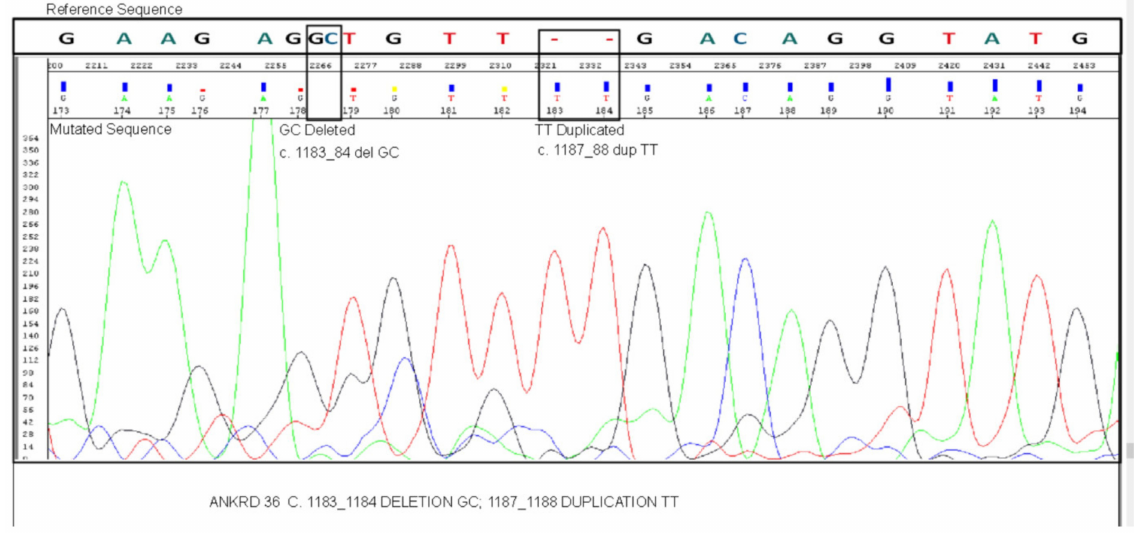
Figure 1. Confirmation of the presence of c.1183_1184 delGC and c.1187_1188 dupTT mutation in ANKRD36 gene by Sanger sequencing in unknown gene variants common in accelerate/blast phase (AP/BC) CML patients (AP, n = 5; BC, n =